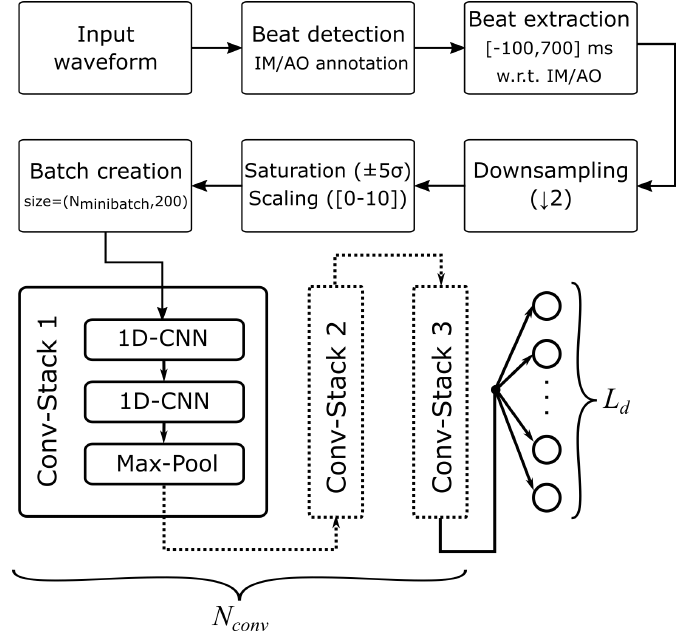
Figure 3. General architecture for processing the input waveforms by means of the VAE network. For clarity’s sake, only the encoder part is represented; the decoder is anti-symmetric. A convolutional stack (Conv-Stack) consists of two cascaded Conv-1D layers and a Max-Pooling one. Many Conv-Stacks can be cascaded (controlled by parameter N conv ), yielding different NN depths. The number of units in the last layer, defining the Latent Dimension L d , is parametric as